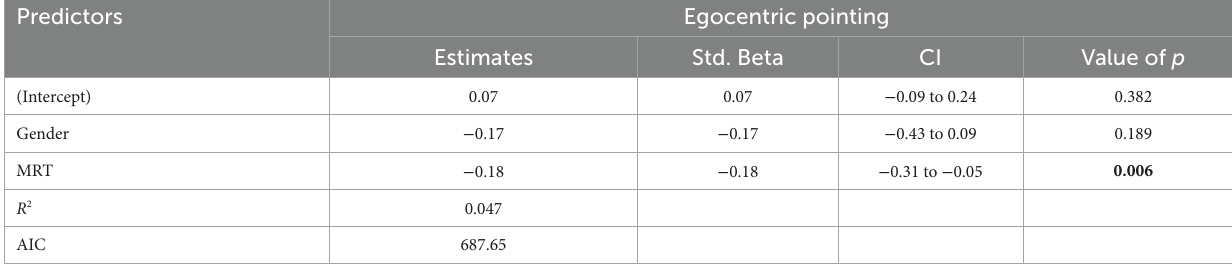
TABLE 2 Results from the best-fitting model for the Egocentric pointing after model selection process.